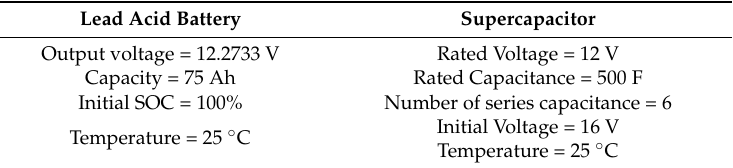
Table 1. Energy storage device parameters. SOC—state-of-charge.